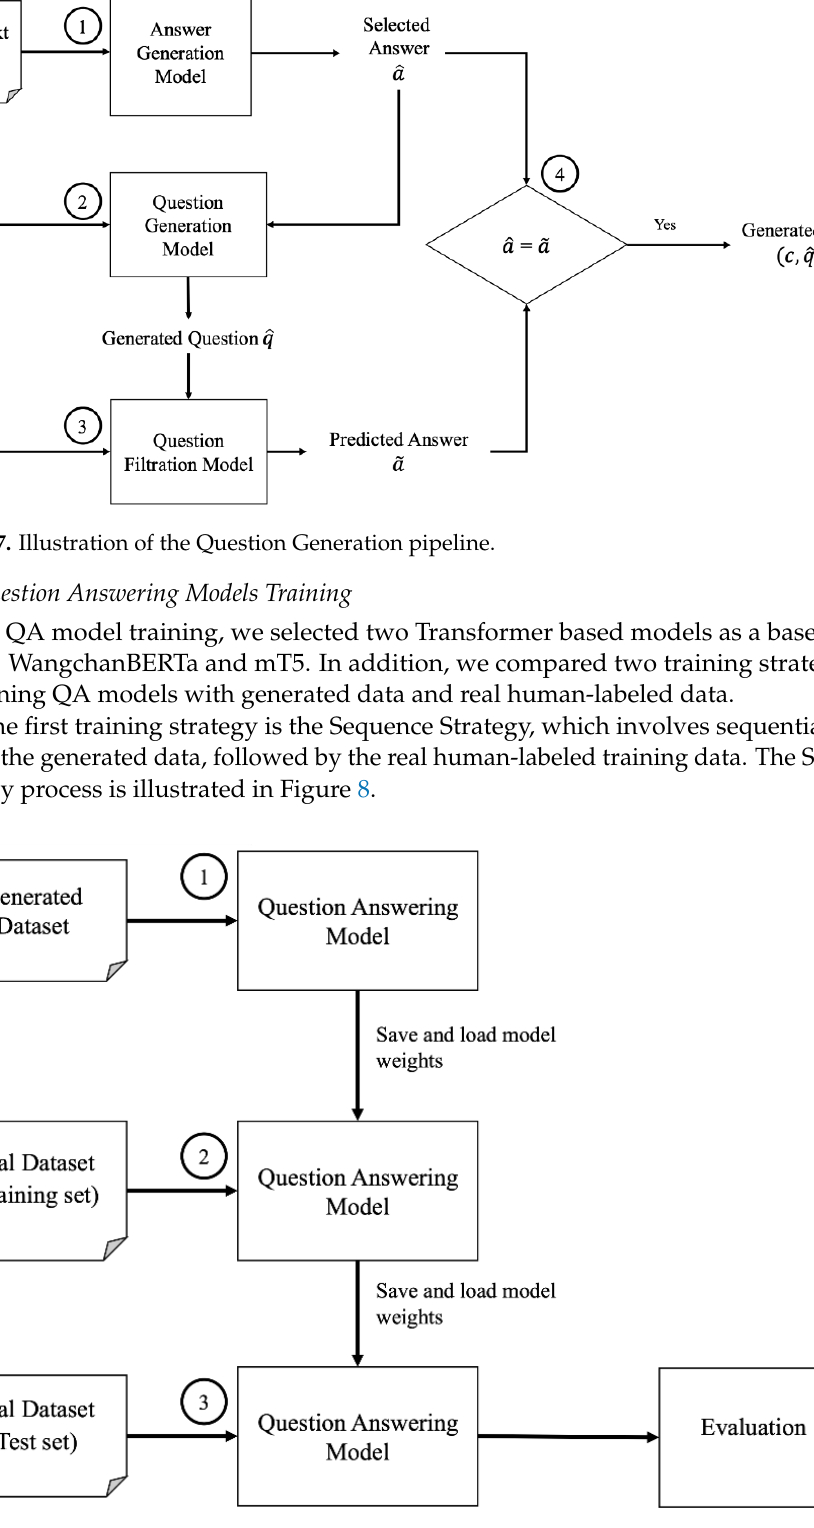
Figure 6. The inputs and the output of the Question Filtration model.